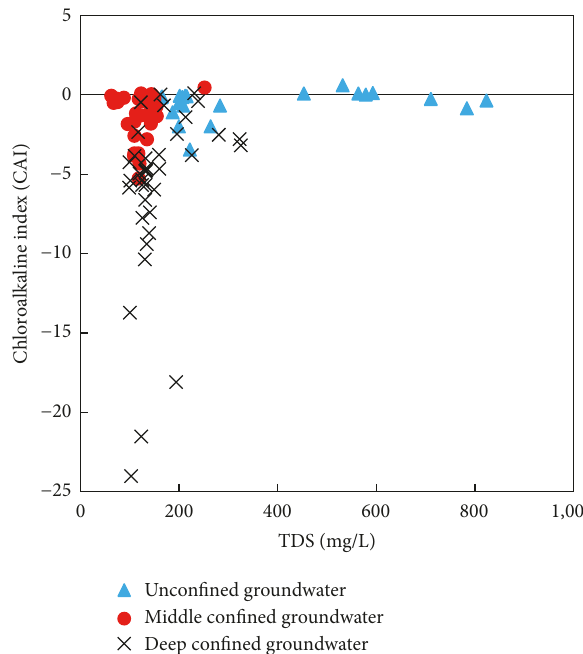
Figure 9: Plot of the chloroalkaline index (CAI) versus TDS of the groundwater in the multilayered aquifers of Zhanjiang.